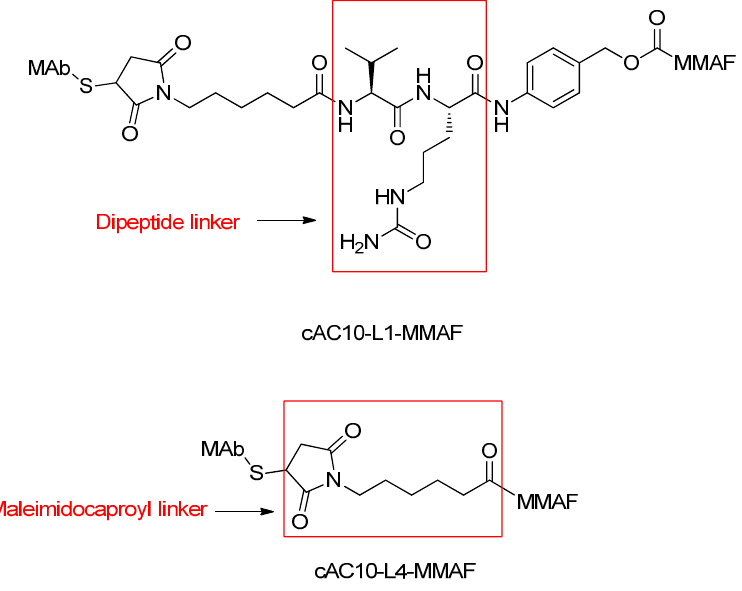
Figure 5. The structural formula of cAC10-L1-MMAF and cAC10-L4-MMAF. Adapted from reference [48,49].